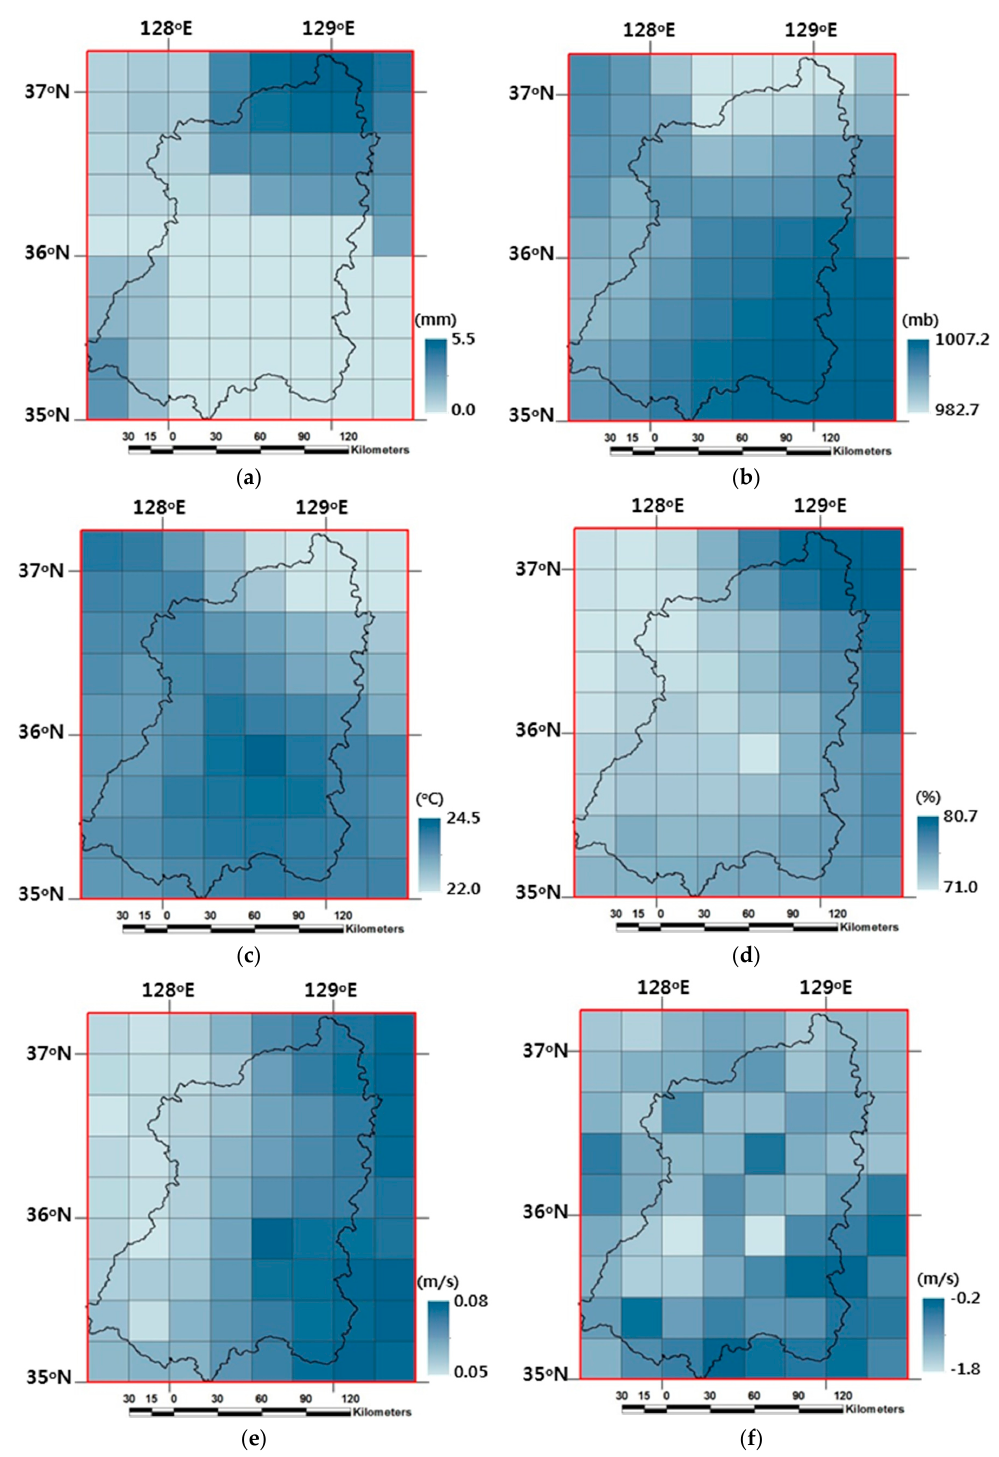
Figure 5 denote spatial distributions of selective meteorological forcing data for the study domain on 5 July, one day of precipitation events in 2009.